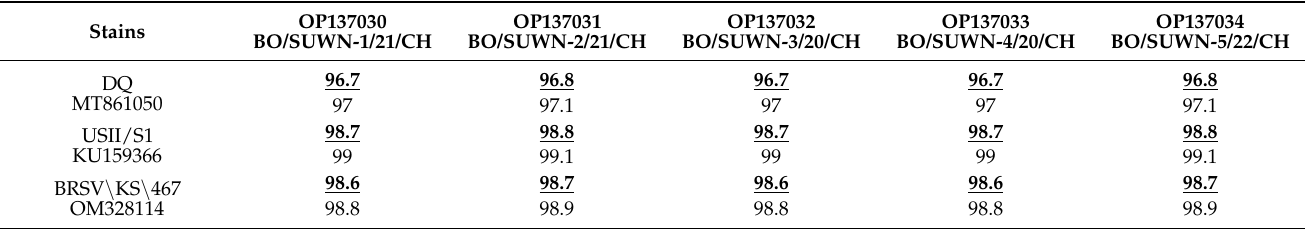
Figure 3. Phylogenetic tree based on the complete nucleotide sequences of F gene. Sequences were compared and clustered by MEGA 7.0 software. The Phylogenetic tree was constructed using the neighbor ‐ joining method (1000 replicates). ● represents 25 F Gene sequences of BRSV strains from this study, represents the F gene sequences of other isolates in China.